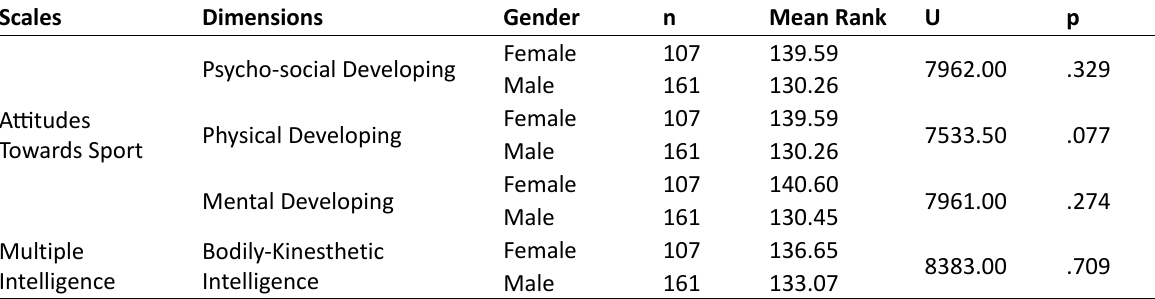
Table 2. Evaluation of the students’ attitudes towards sport and bodily-kinesthetic intelligence by gender.